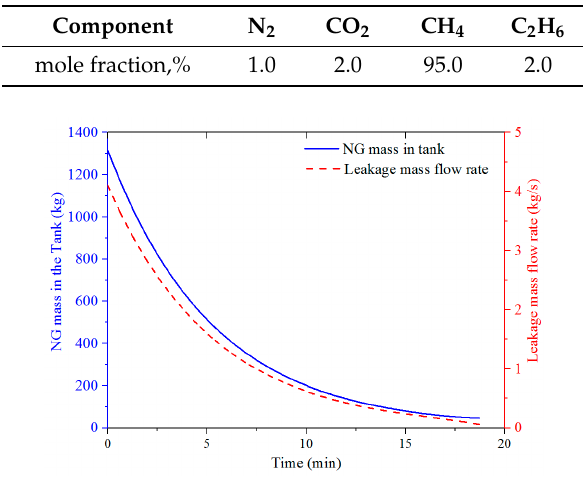
Figure 7. Changes in the residual natural gas mass in the tank and the leakage mass flow rate over the leakage duration time.